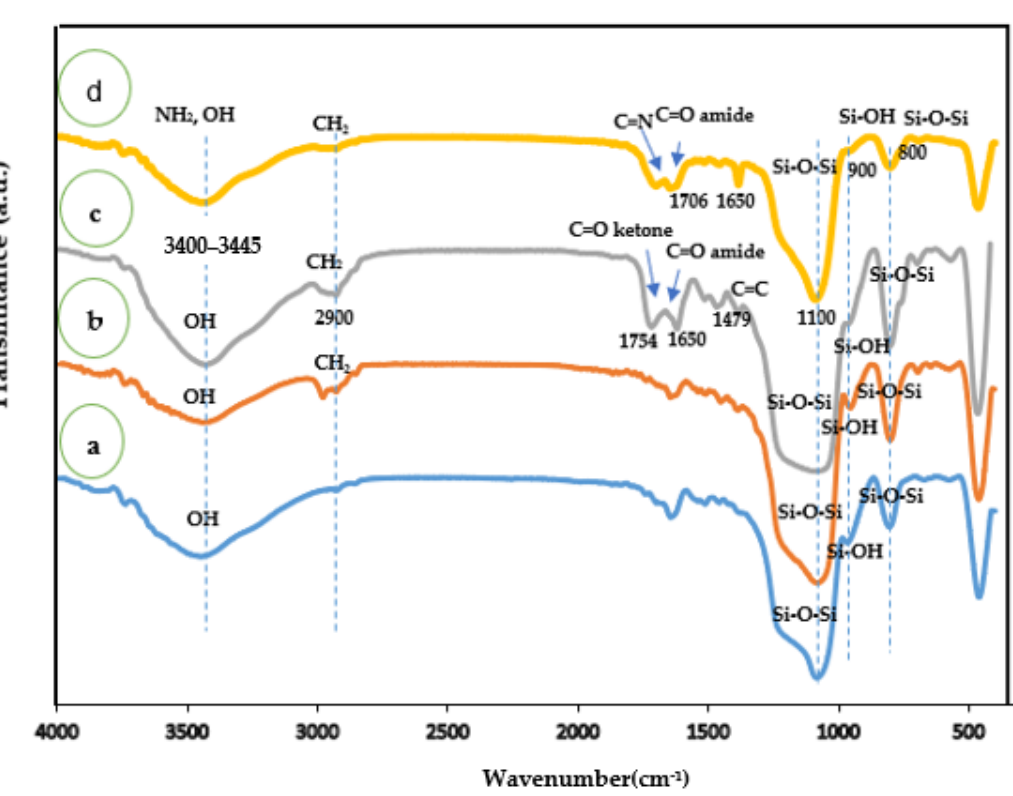
Figure 1. FT-IR spectra of ( a ) SBA-15, ( b ) SBA-Pr-Cl, ( c ) SBA-Pr-Is, and ( d ) SBA-Pr-Is-TAP.